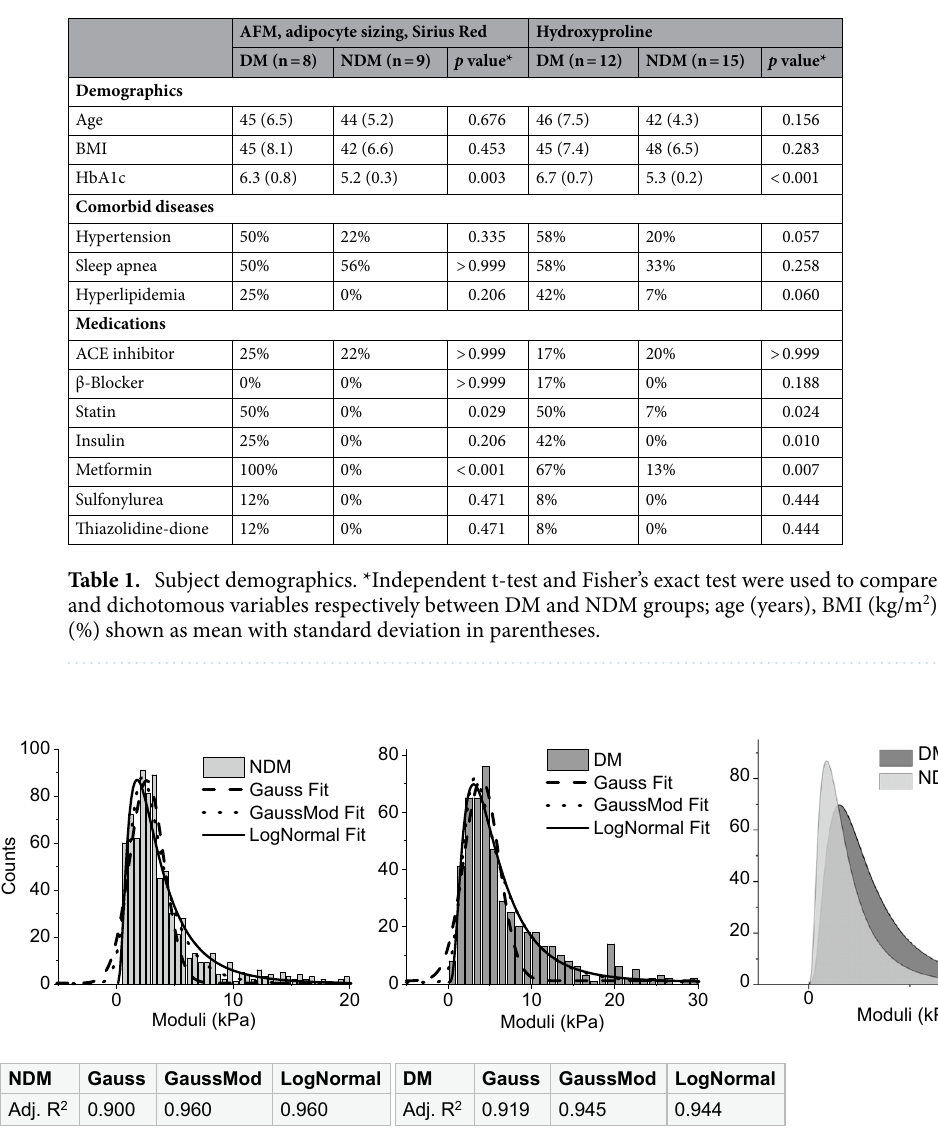
Figure 2. Raw DM and NDM moduli data with Gauss, GaussMod, and LogNormal distribution fits (left). LogNormal distribution fits shaded for both DM and NDM adipose tissues